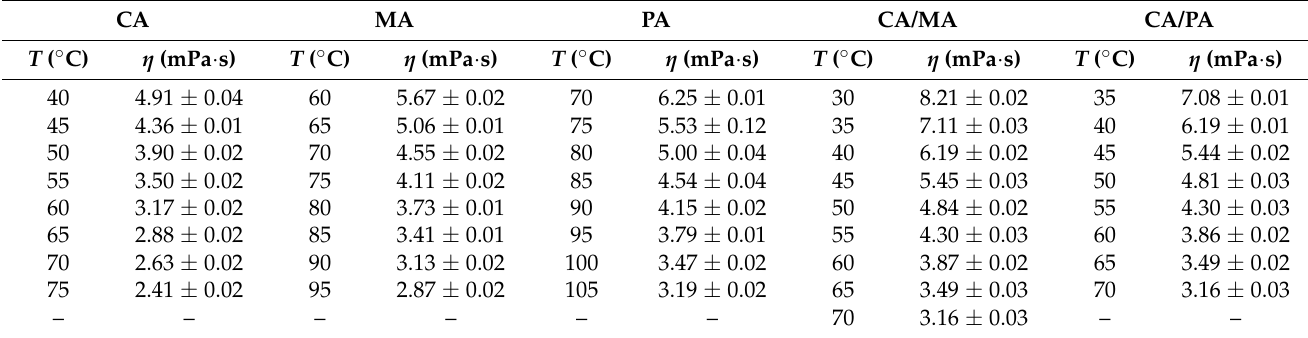
Table 10. Measured viscosities of the materials studied at pressure p = 0.1 MPa *.